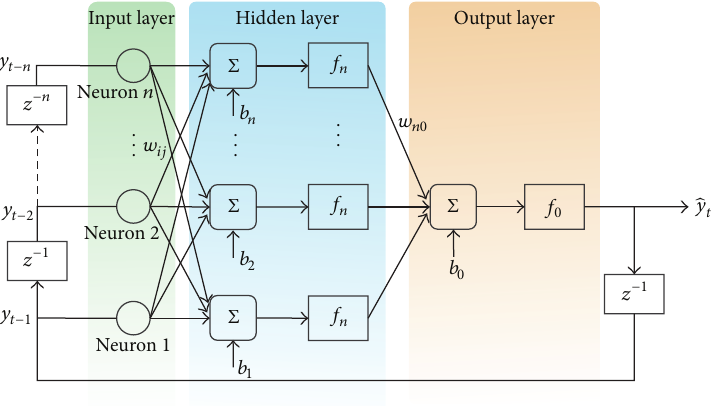
Figure 1: The structure of NAR neural